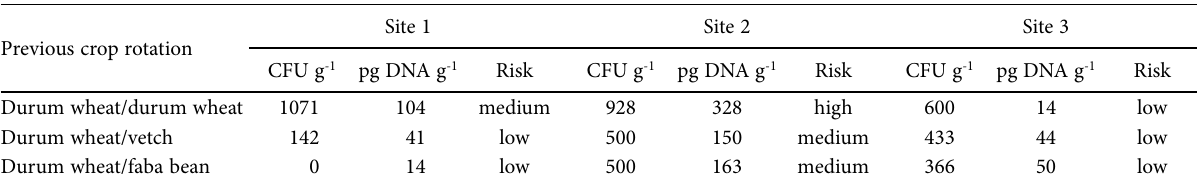
Table 3. Number of colony forming units (CFU g -1 of soil), levels of DNA (pg DNA g -1 soil) of Fusarium culmorum 1 year after treatment at three demonstration trial sites, and risk of resultant crop losses (Predicta® B